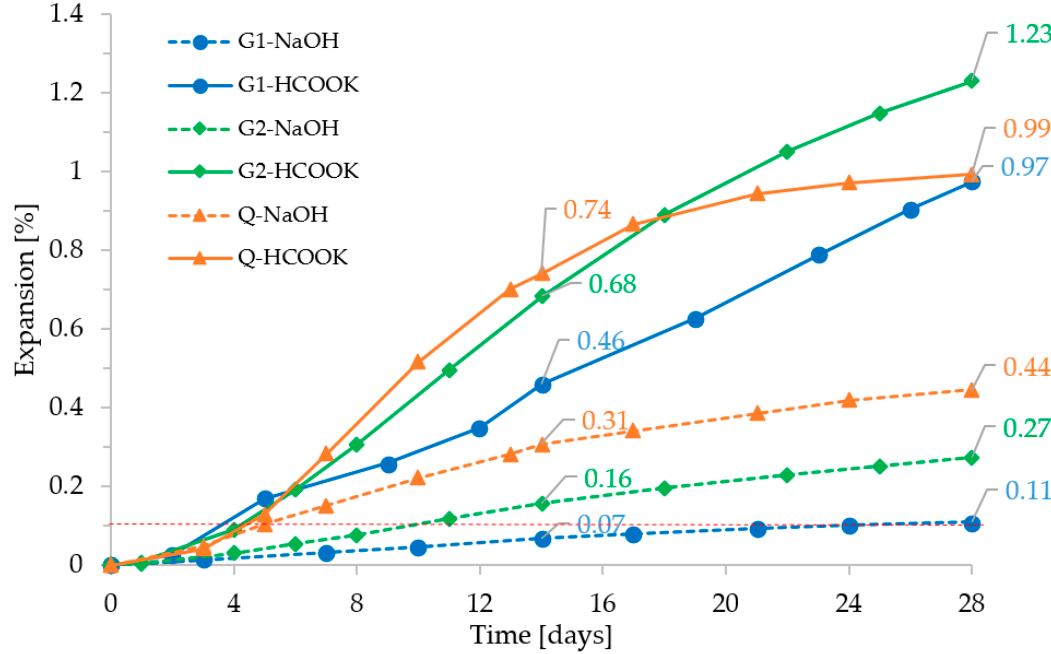
Figure 2. Expansion of mortar bars with aggregate with different ASR reactivity (R0, R1, R2) exposed to 1 M NaOH or 50% HCOOK solution.